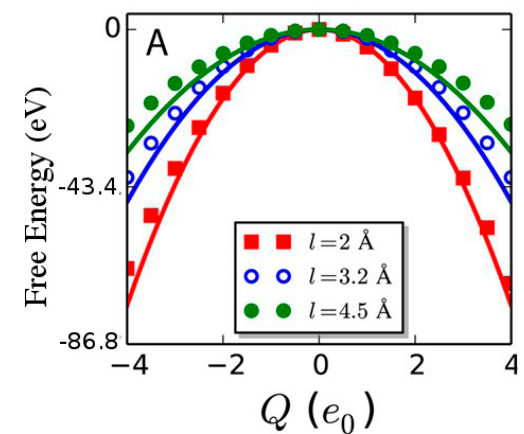
Ion solvation free energy components for the short-range (empty cav- ity first) model computed from an MD model of NaCl in SPC/E water. R is the cavity radius, ‘HS’ denotes the cavity formation cost, ‘LR’ is the full ion- SPC/E water interaction after a cavity is present, and ‘IS’ is the free energy of removing the cavity Figure 5. Comparing components of the SR-first (left) and LR-first (right) calculations of the free energy gained on dissolving a charged ionic species in